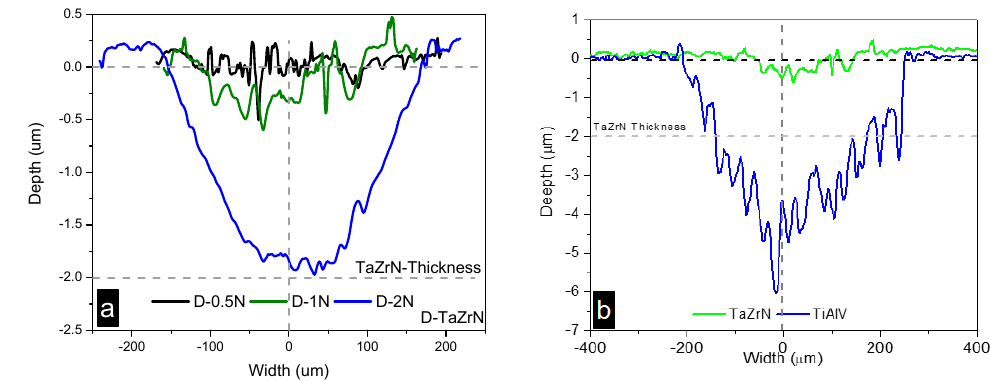
Figure 7. ( a ) Wear track profile of coated surfaces as a function of load; ( b ) comparison between the wear track profile of coated and uncoated samples at loads of 1 N.